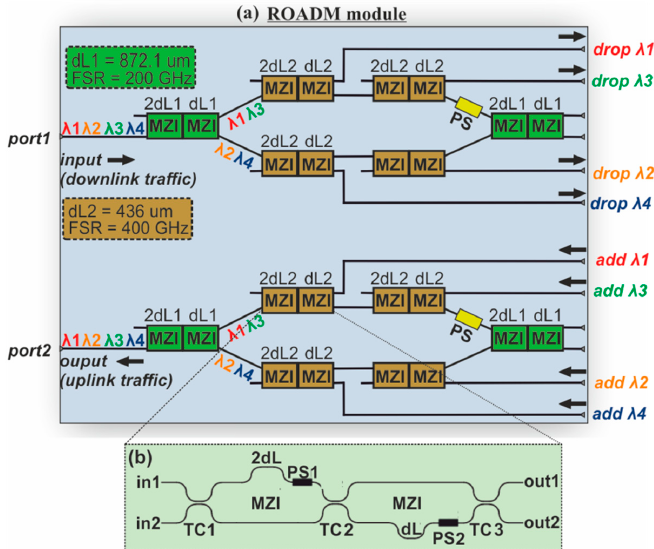
Figure 4. ( a ) ROADM physical layer design and implementation comprising the identical drop- enabling and the add-enabling circuitries, both based on cascaded Mach-Zehnder Interferometers (MZIs), ( b ) building block of the cascaded MZIs. ( b ) building block of the cascaded